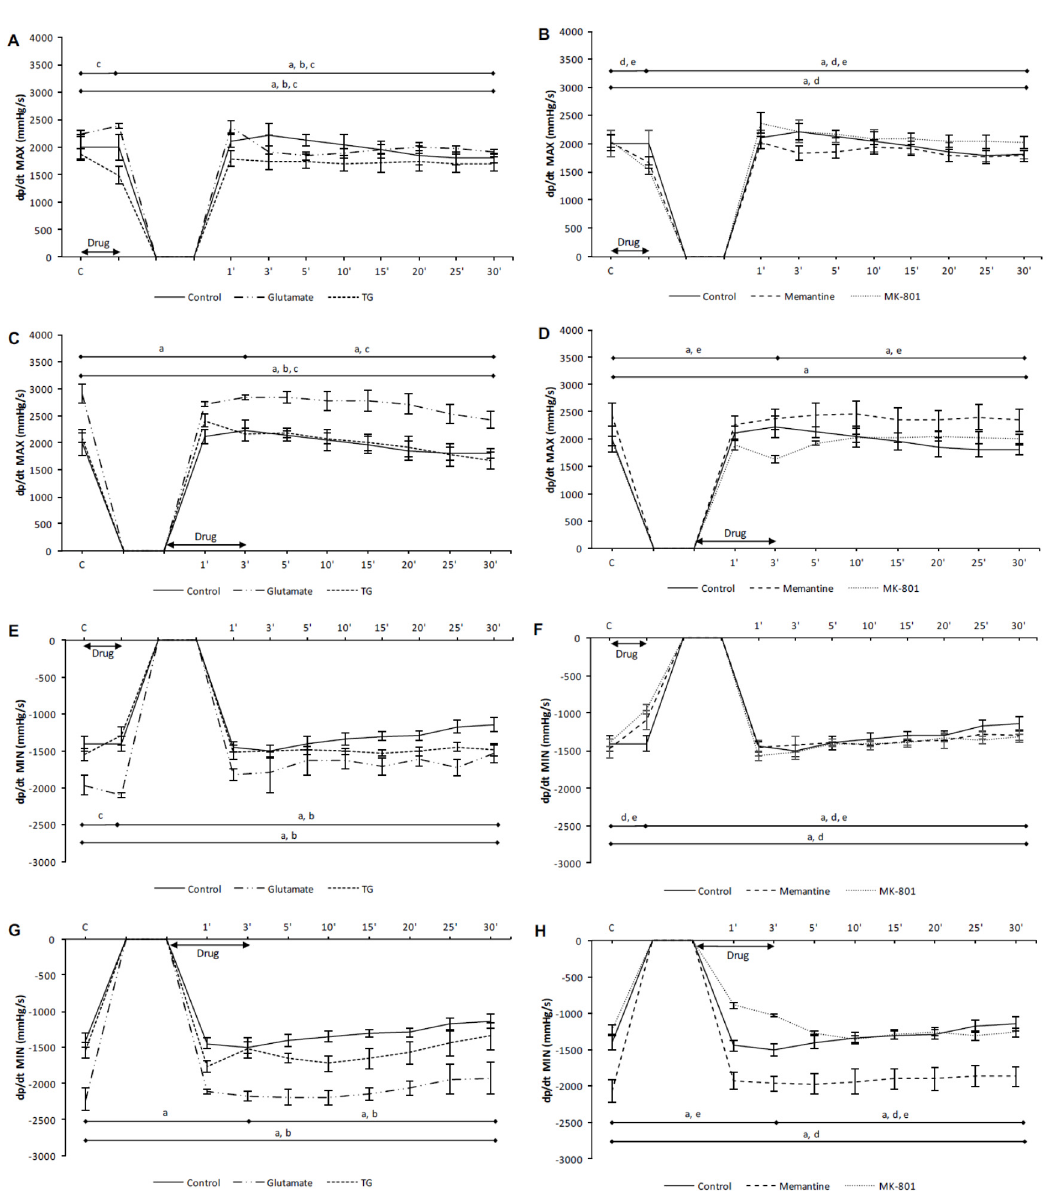
Figure 1. The e ff ects of cardiac N-methyl-D-aspartate receptor (NMDAR) modulation in preC and postC onparametersofcardiaccontractility. ( A , E )preconditionedwithglutamateandTG;( B , F )preconditioned with memantine and MK-801; ( C , G ) postconditioned with glutamate and TG; ( D , H ) postconditioned with memantine and MK-801. dp / dt max—maximum rate of pressure development in the left ventricle; dp / dt min—minimum rate of pressure development in the left ventricle; TG—(RS)-(Tetrazol-5-yl)glycine; preC—preconditioning; postC—postconditioning. Statistical significance between points of interest was presented as: a—in control group; b—in glutamate group; c—in TG group; d—in memantine group; e—in MK-801 group. Statistical significance was considered significant if the p value was less than 0.05 ( p <